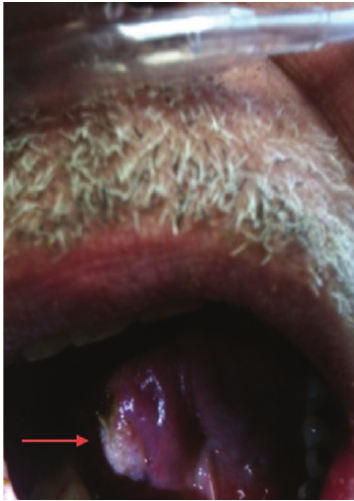
Figure 1: A 1 . 5 × 1 . 5 cm ulceration with slightly heaped boarders on the right lateral anterior oral tongue.